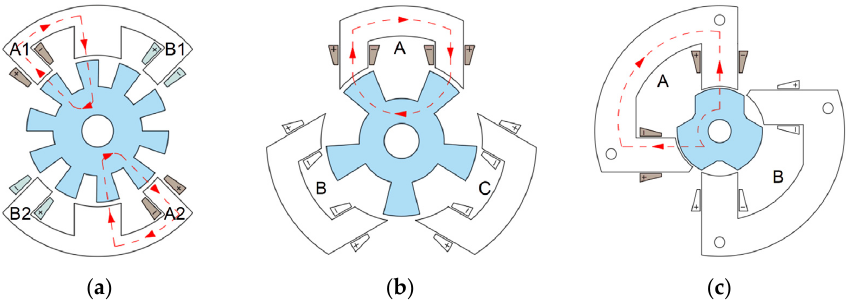
Figure 15. SRM with segmental stators. ( a ) is 6/10 with E-core stators; ( b ) and ( c ) are 6/5 and 4/3 C-core stators which are used in high-speed applications, respectively.